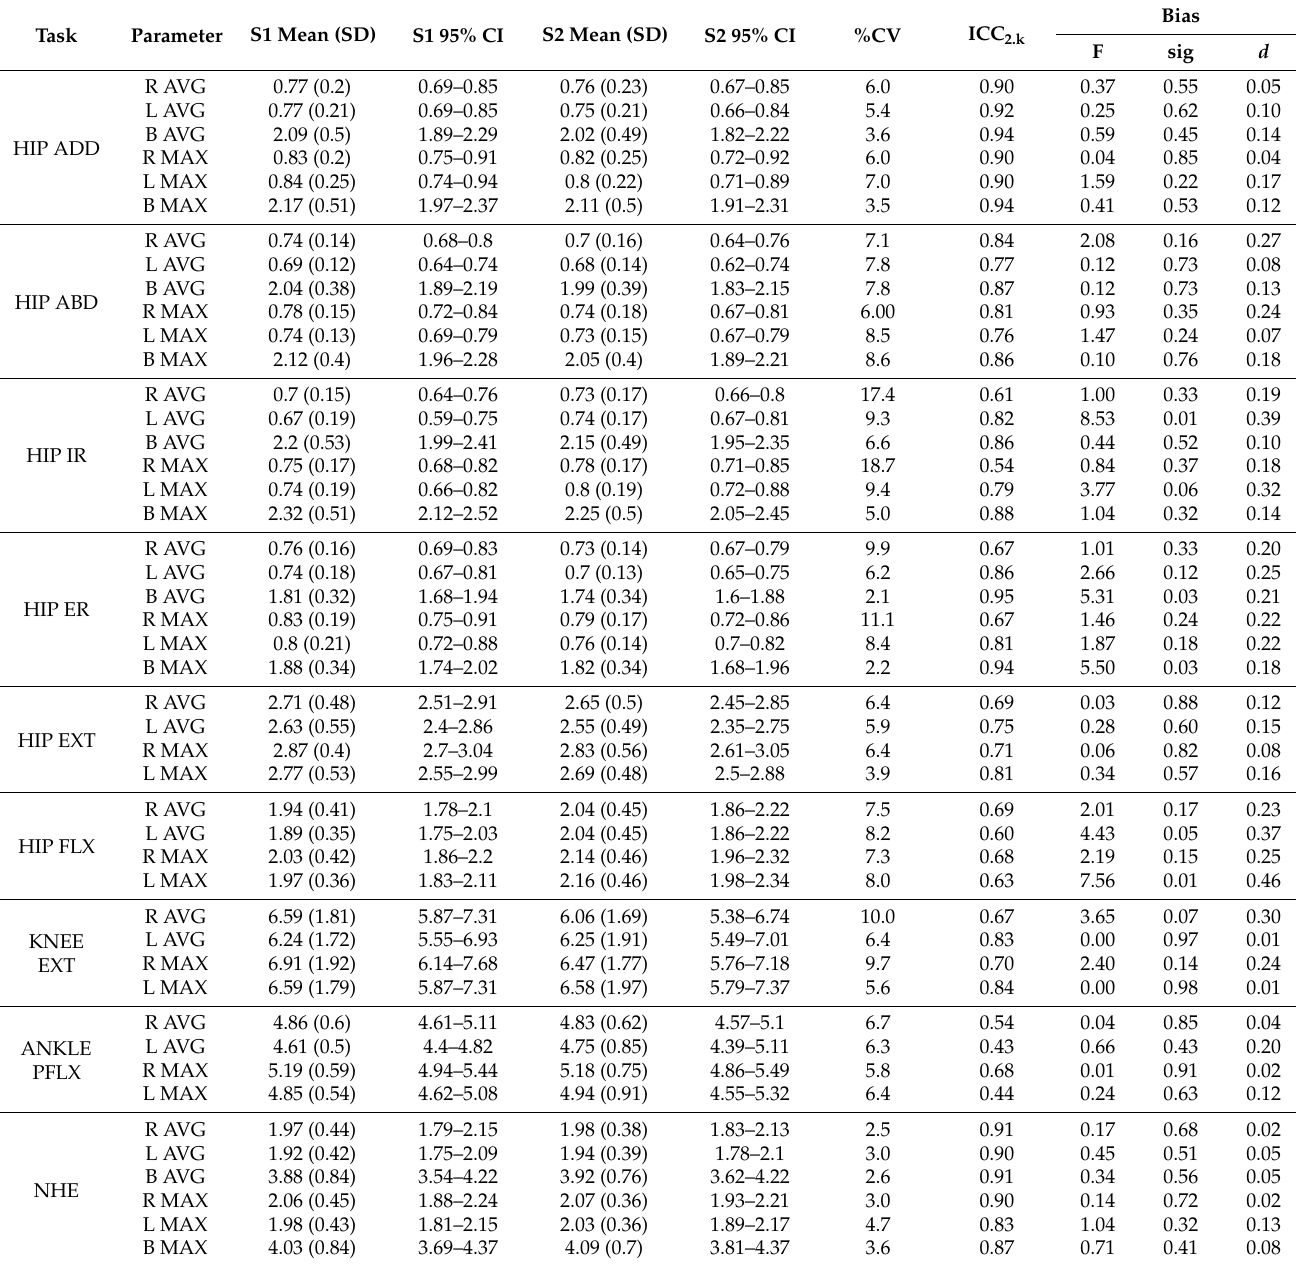
Table 2. Intra-session reliability-peak torque